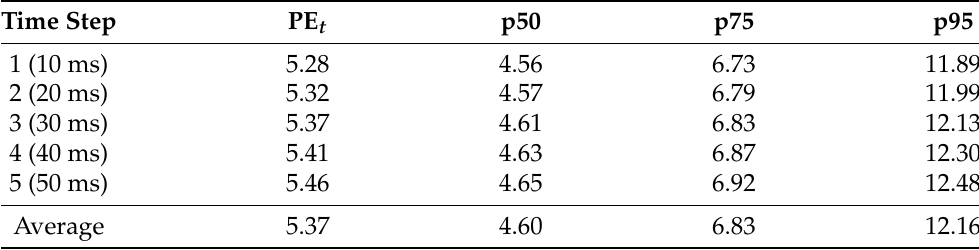
Table 4. Baseline performance for gaze prediction, reported in terms of Prediction Error (PE) between predicted and ground-truth 3D gaze vectors, in degrees. p50, p75, and p95 scores denote the 50th, 75th, and 95th percentile scores of the PE t distribution,